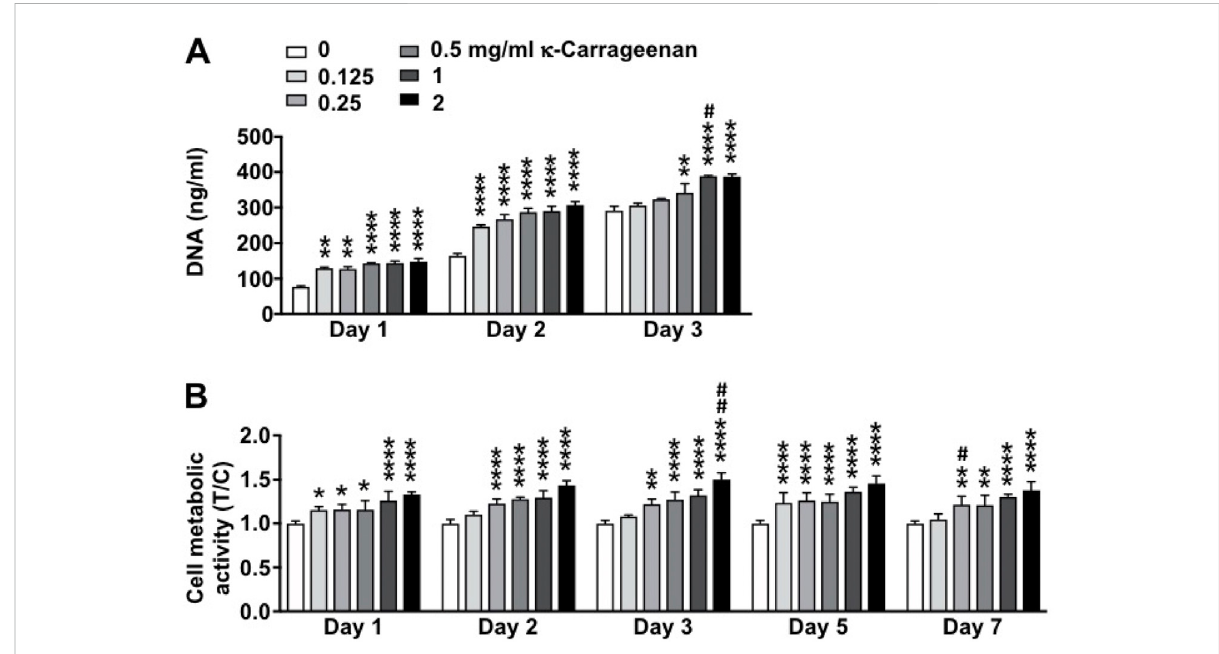
FIGURE 6 Dose-dependent effect of κ -carrageenan in OCP-coating of titanium discs on MC3T3-E1 pre-osteoblasts proliferation (day 1, 2, 3) and metabolic activity (day 1 – 7). (A) Total cellular DNA content. (B) Presto-blue cell metabolic activity. Data are expressed as κ -carrageenan-treated- over-control (T/C) ratio. Values are mean ± SD. n = 3 from 3 independent experiments. Signi fi cant effect of κ -carrageenan, * p < 0.05, ** p < 0.01, **** p < 0.0001, # p < 0.05, ## p <